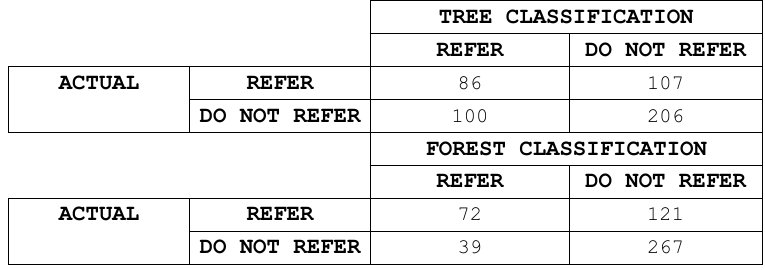
Table 14. Pixel value results.